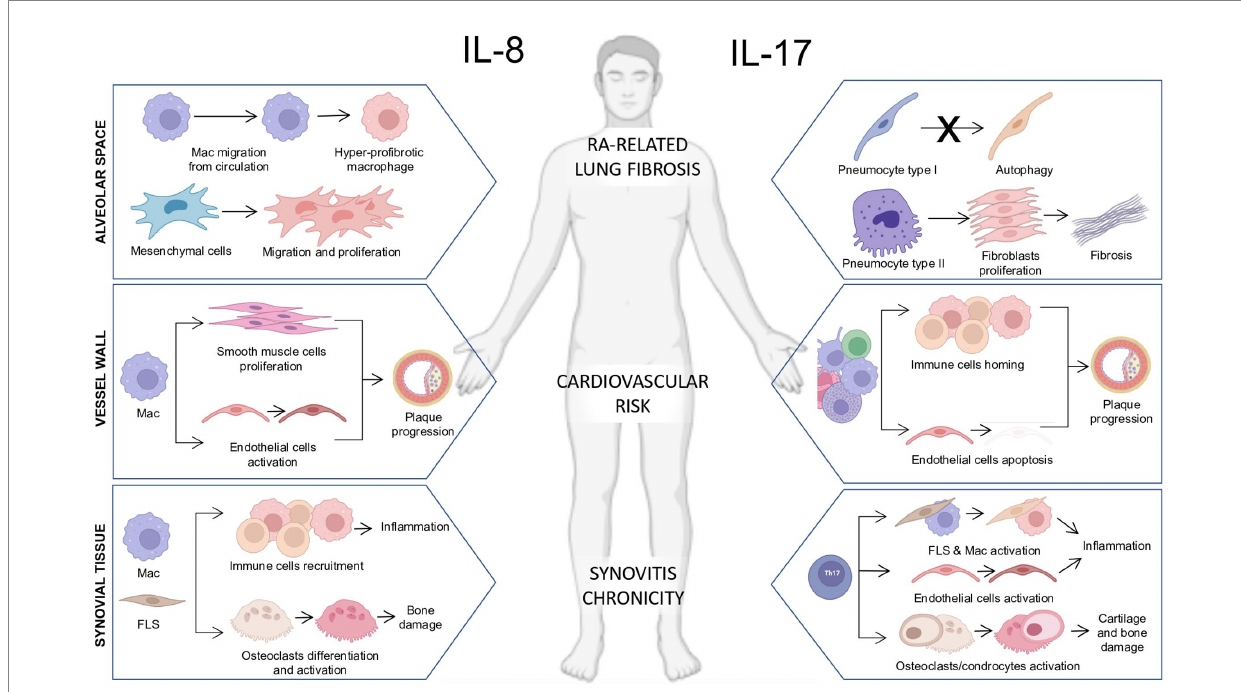
FIGURE 1 Pathogenetic actions of interleukin-8 (IL-8) and IL-17 on immune and stromal cells in multiple biological compartments in rheumatoid arthritis. (Left section) Schematic representation of the pathogenetic actions of IL-8 in the synovial tissue, blood vessel wall, and alveolar space in RA. Synovial tissue : The release of IL-8 by resident macrophages and fibroblast-like synoviocytes (FLS) plays a chemotactic action promoting the recruitment of immune cells toward the synovial tissue fueling tissue inflammation and promoting osteoclasts differentiation and activation leading to bone damage. Vessel wall : The release of IL-8 by infiltrating macrophages promotes the proliferation of smooth muscle cells and the activation of endothelial cells promoting plaque progression. Alveolar space : The release of IL-8 by alveolar macrophages enhances myeloid cell migration from circulation and promotes the development of hyper-fibrotic macrophages. Moreover, the release of IL-8 from mesenchymal cells induces their migration and proliferation in an autocrine loop. (Right section) Schematic representation of the pathogenetic actions of IL-17 in the synovial tissue, blood vessel wall, and alveolar space in RA. Synovial tissue : The release of IL-17 by Th17 lymphocytes promotes the activation of synovial macrophages and FLS contributing to the chronicity of synovitis. Moreover, IL-17 is a potent inducer of osteoclast/chondrocyte activation contributing to bone and cartilage damage. Vessel wall : The release of IL-17 by adaptive and innate immune cells promotes the chemotaxis of immune cells within the vessel plaque and promotes endothelial cell apoptosis, accelerating the atherosclerotic process and leading to increased cardiovascular risk. Alveolar space : The release of IL-17 interferes with the pneumocyte I autophagy process and its release by pneumocytes type II enhances fibroblast proliferation, which contributes to extracellular matrix deposition and lung